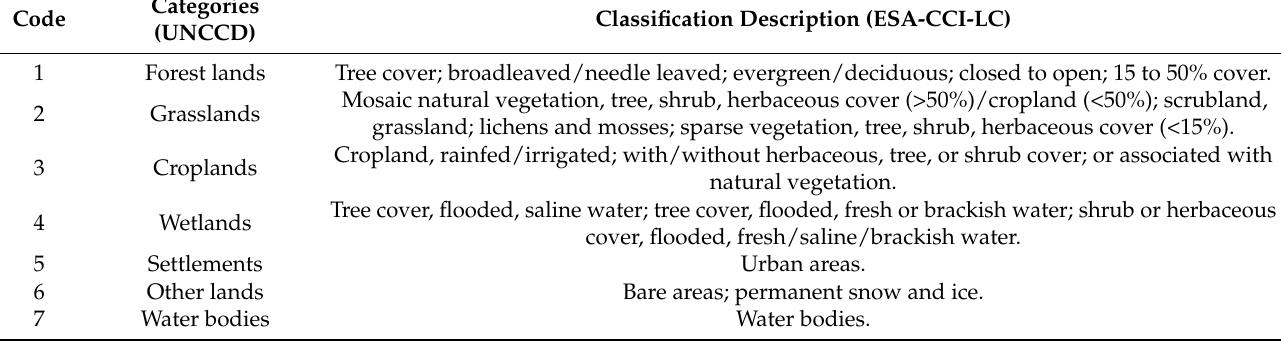
Table 1. Land Cover (LC)